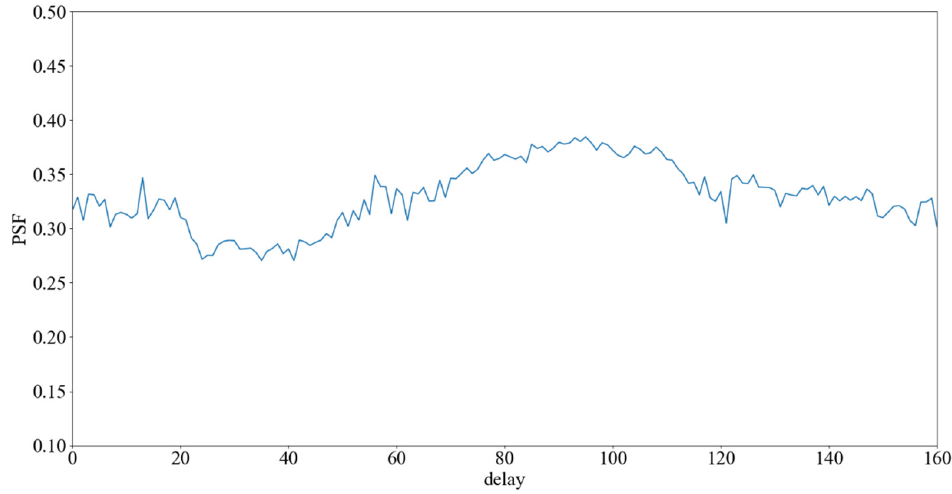
Figure 7. Effect of time delay on PSF in three neurons model 1(b-2).